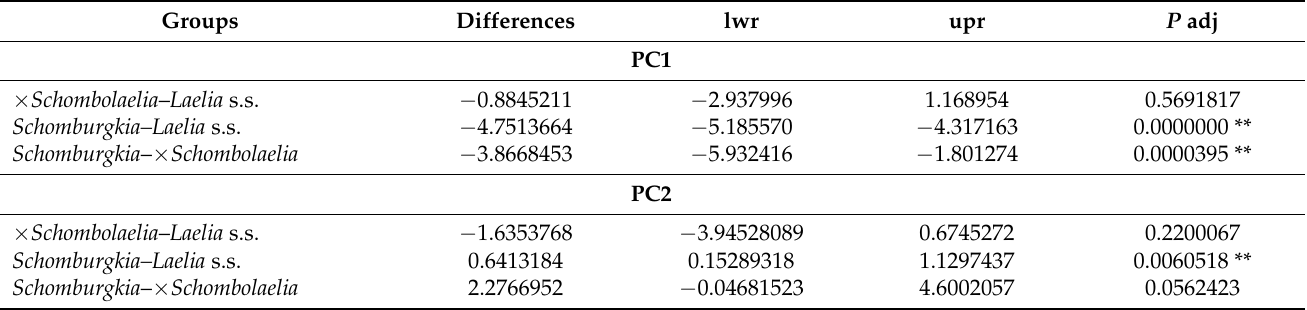
Table 4. The analysis of variance by principal